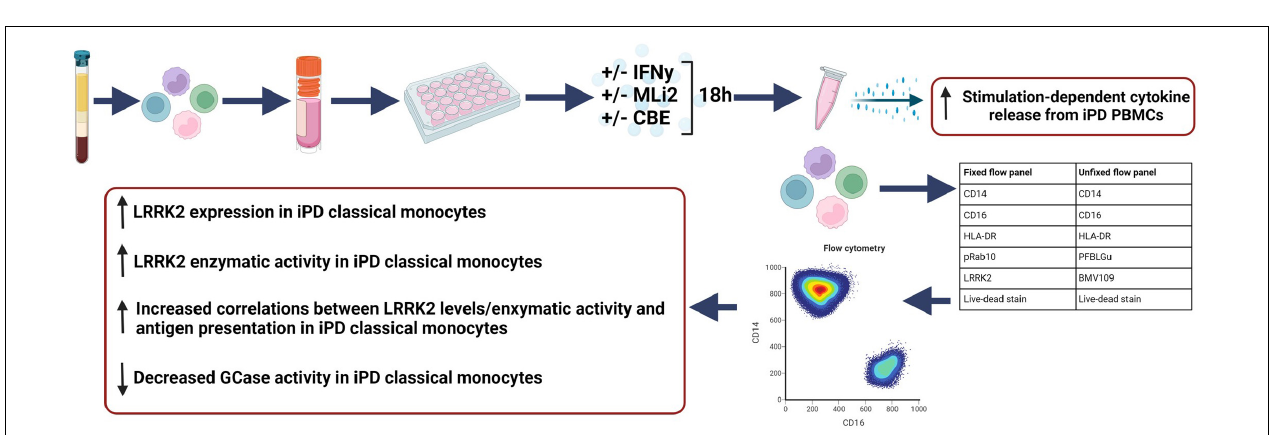
FIGURE 6 | WHOPPA enables identification of increased cytokine release from PD PBMCs. Conditioned media from plated PBMCs were collected and cytokine expression levels were measured in the media on V-PLEX pro-inflammatory human panel (Meso Scale Discovery) on a QuickPlex instrument. µ g/mL was calculated and normalized to live cell percentage to account for differences between samples. Fold-change from baseline was then calculated for IL-10 (A) , IL-13 (B) , IL-1 β (C) , IL-2 (D) , IL-4 (E) , IL-6 (F) IL-8 (G) , and TNF (H) . Bars represent mean ± SEM ( N = 13/15). Two-way ANOVA, Bonferroni post-hoc , groups sharing the same letters are not significantly different ( p > 0.05) whilst groups displaying different letters are significantly different ( p < 0.05) whilst groups displaying the same letter are significantly different ( p < 0.05). Lowercase letters in the colors of the two cohorts denote post-hoc analysis of disease status within treatments.